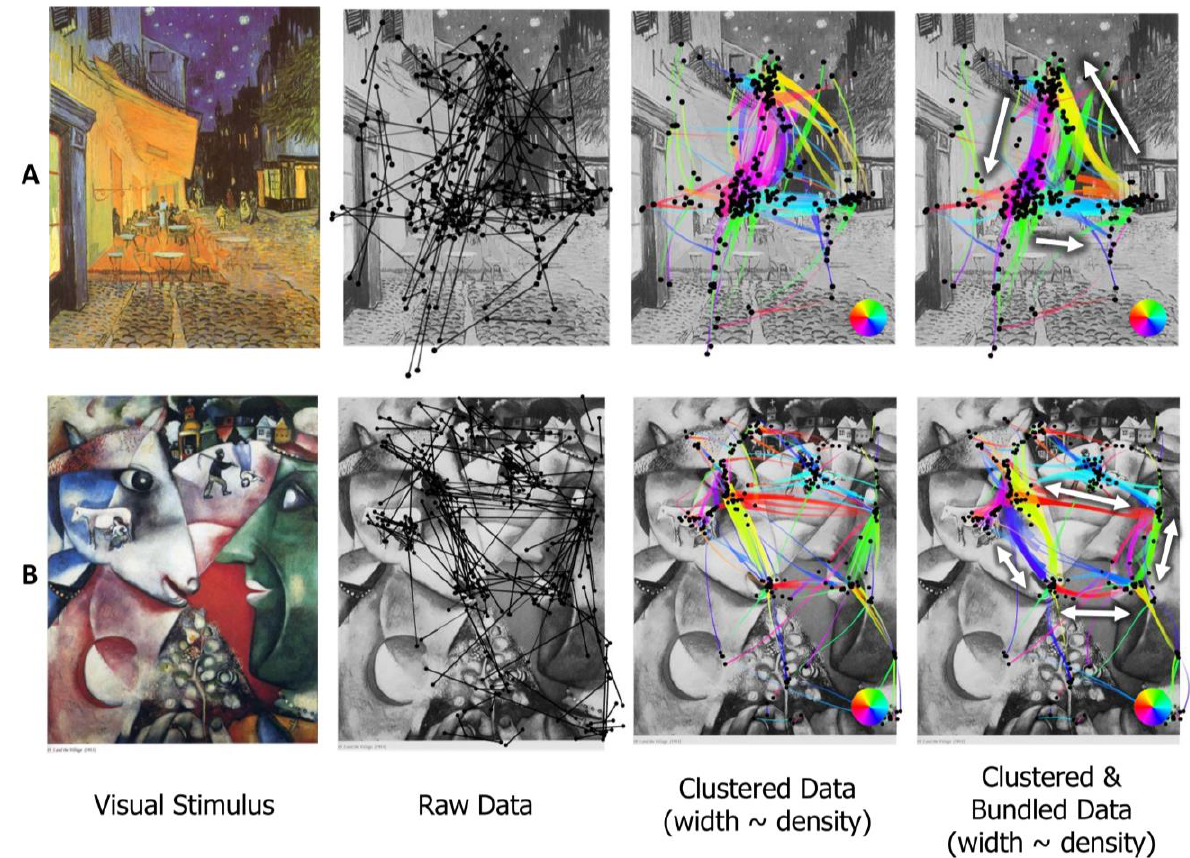
Figure 7. The scanpath visualization for the Vincent van Gogh (A) and Marc Chagall (B)